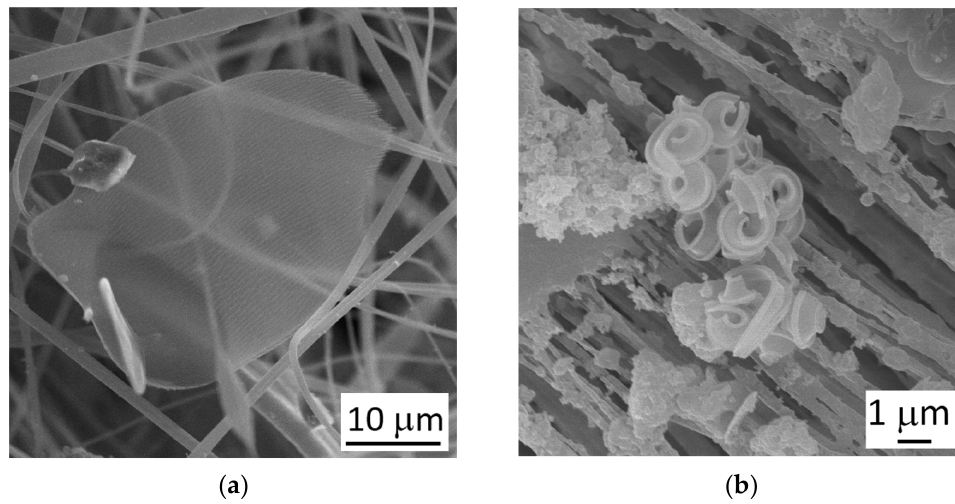
Figure 4. SEM images of other types of PBA: ( a )—flat insect scale, ( b )—epicuticular wax of a plant.